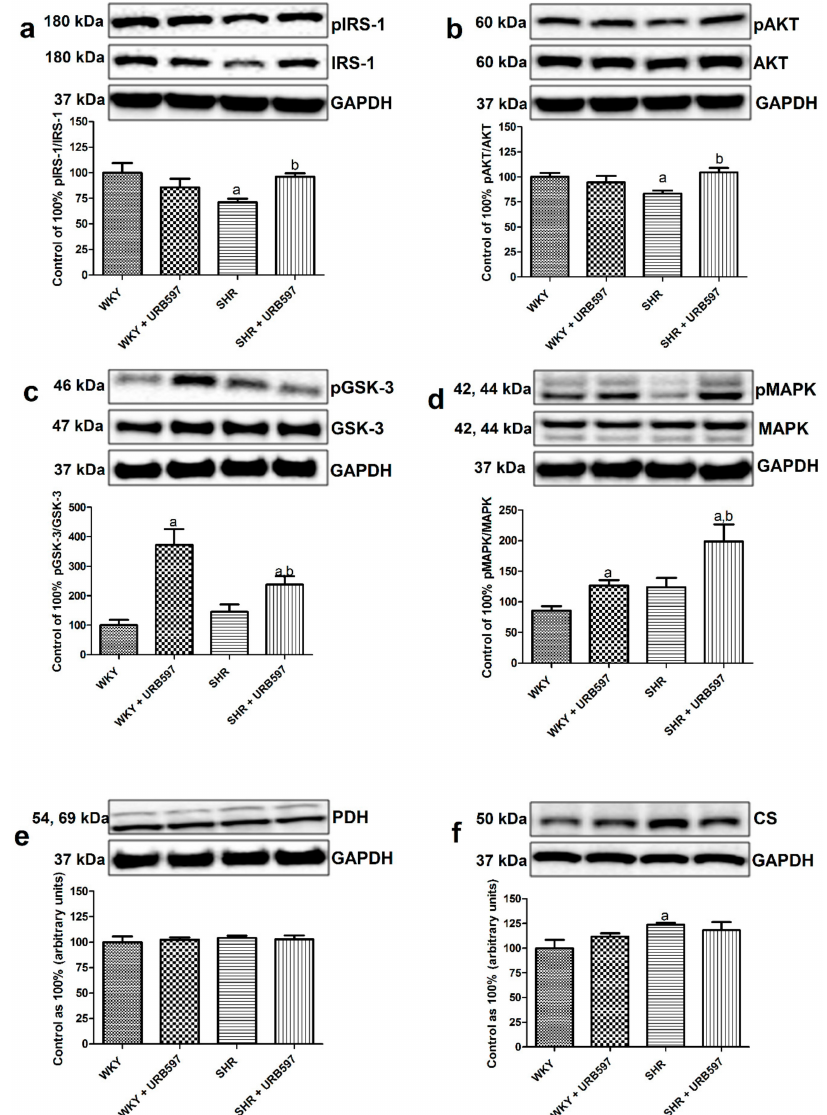
Figure 3. The e ff ect of chronic URB597 treatment on the ratio of total expression of phosphorylated and unphosphorylated proteins involved in insulin signaling pathway, i.e., phosphorylated insulin receptor substrate 1 / insulin receptor substrate 1—pIRS-1 / IRS-1 ( a ), phosphorylated protein kinase B / protein kinase B—pAKT / AKT ( b ), phosphorylated glycogen synthase kinase 3 / glycogen synthase kinase 3 pGSK-3 / GSK-3 ( c ), and phosphorylated mitogen-activated protein kinase / mitogen-activated protein kinase—pMAPK / p44 / 42 MAPK ( d ) as well as total expression of pyruvate dehydrogenase—PDH ( e ) and citrate synthase—CS ( f ) in the left ventricle in the control Wistar Kyoto rats (WKY) and